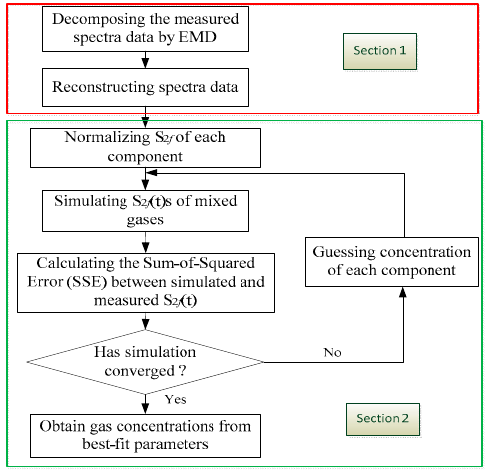
Figure 3. Multi-spectral fitting flow chart [23].